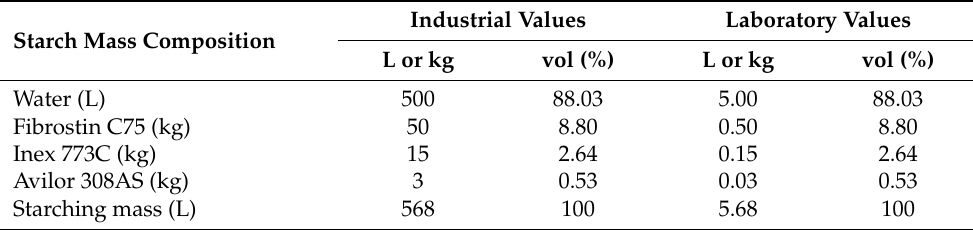
Table 3. Starch agents and their proportions in starch mass. Starch Mass Composition